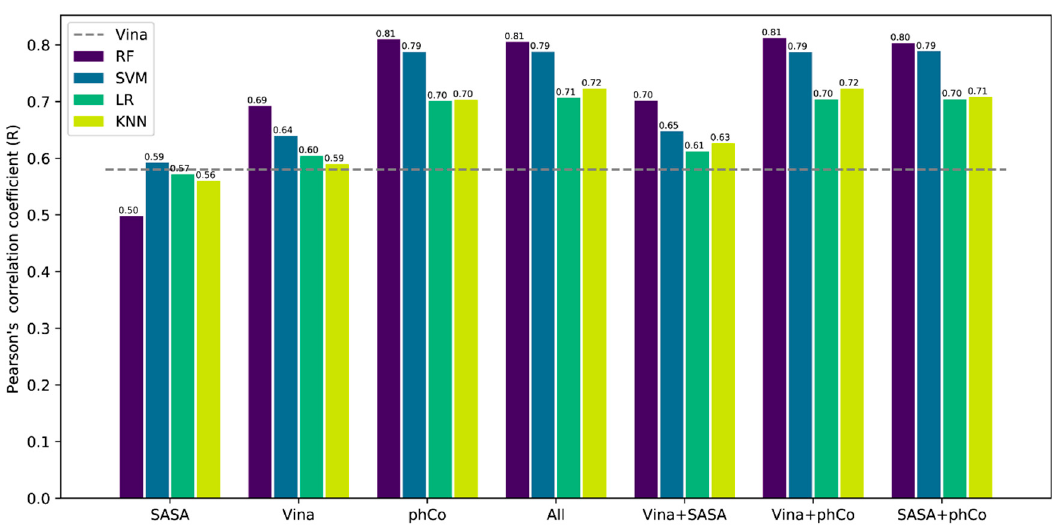
Figure 2. Comparison of the contribution of each class of features in the various machine-learning models (SVM: support vector machine, LR: linear regression, RF: random forest and KNN: k-nearest neighbor). SASA refers to a solvent-accessible surface area, Vina refers to AutoDock Vina’s energy terms and phCo refers to intermolecular contacts. The dotted line indicates the baseline performance represented by AutoDock Vina.